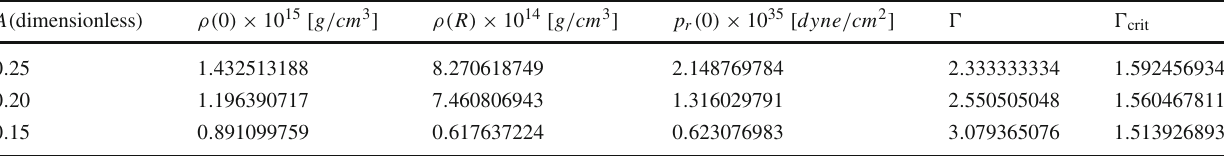
Table 2 The numerical values of some thermodynamic observables for a fixed radius R = 9 . 5 [ km ] and for different values of the parameter A A ( dimensionless